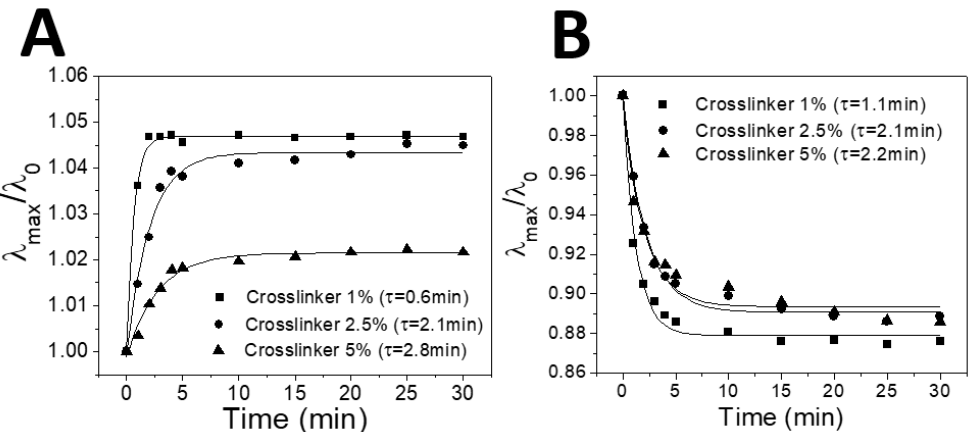
Figure 5. Response kinetics for ( A ) swelling (humidity changes from 1% to 40% RH) and ( B ) deswelling (humidity changes from 80% to 40% RH) of three IOPGs with different crosslinking densities. Solid curves are the exponential fitting to the respective plots, and the obtained time constants ( τ ) are shown. The IOPG with the lowest crosslinking density (1 wt %) shows the most rapid swelling and deswelling kinetics.